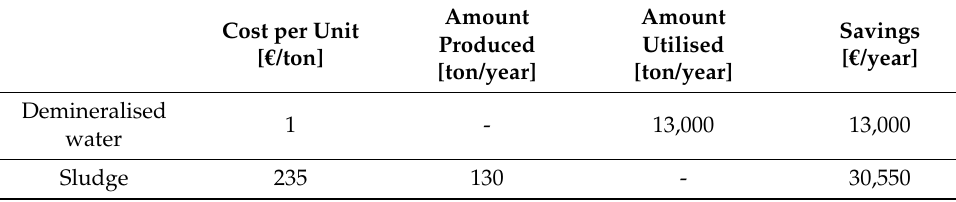
Table 6. Cost due to demineralised-water production and sludge